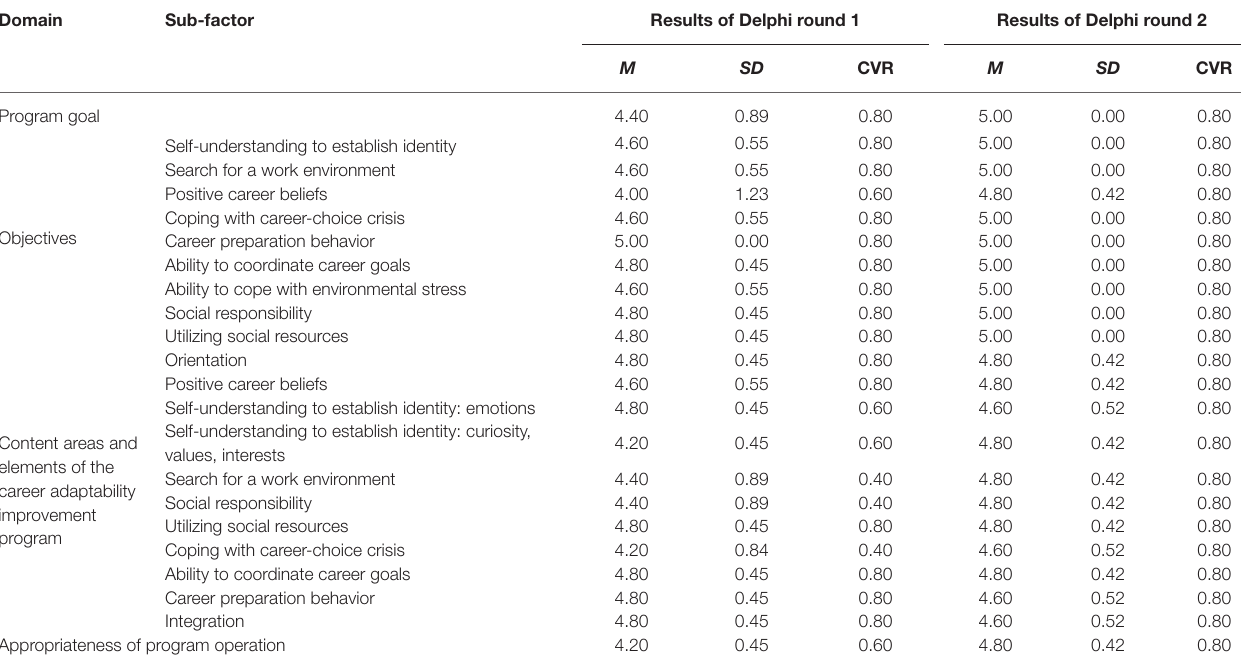
TABLE 2 | Results of Delphi survey for content validation.